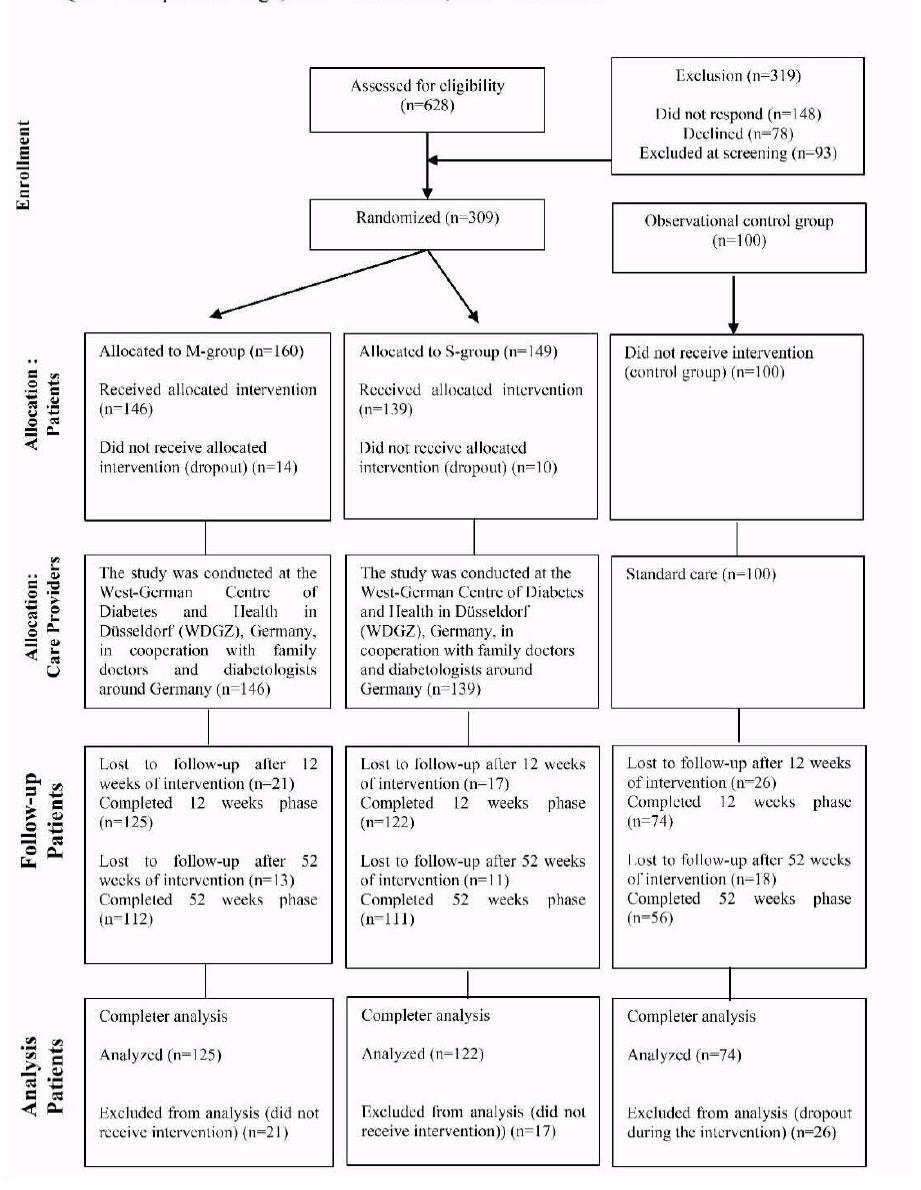
Figure 1. Flow chart.